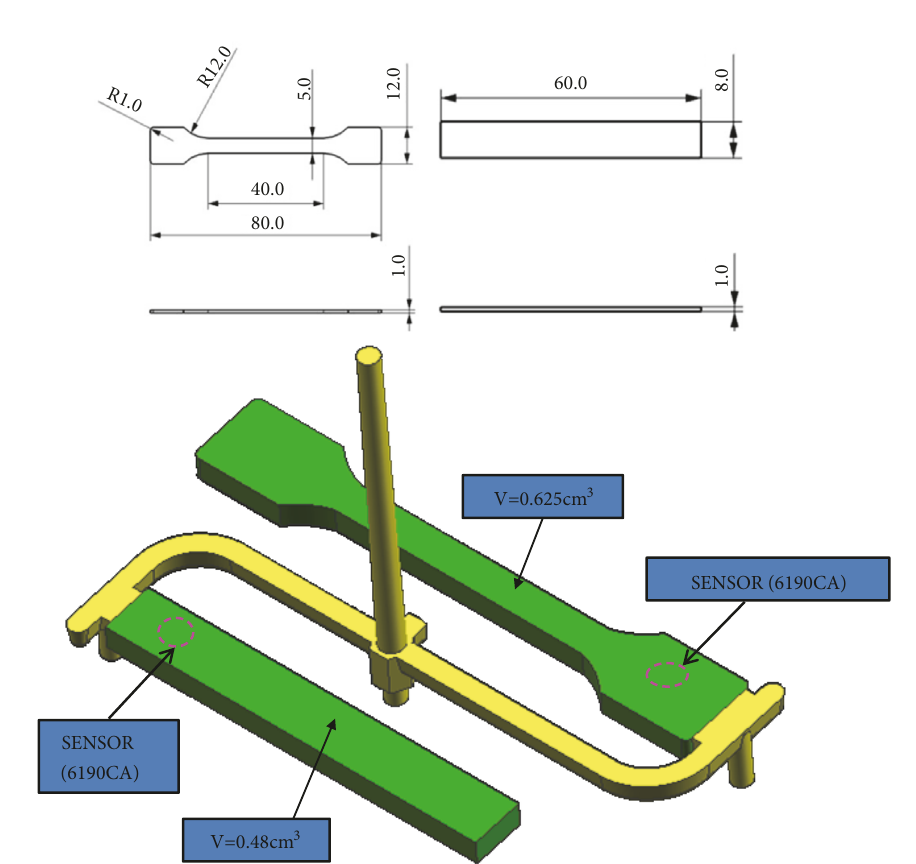
Figure 2: Dimension of specimen and